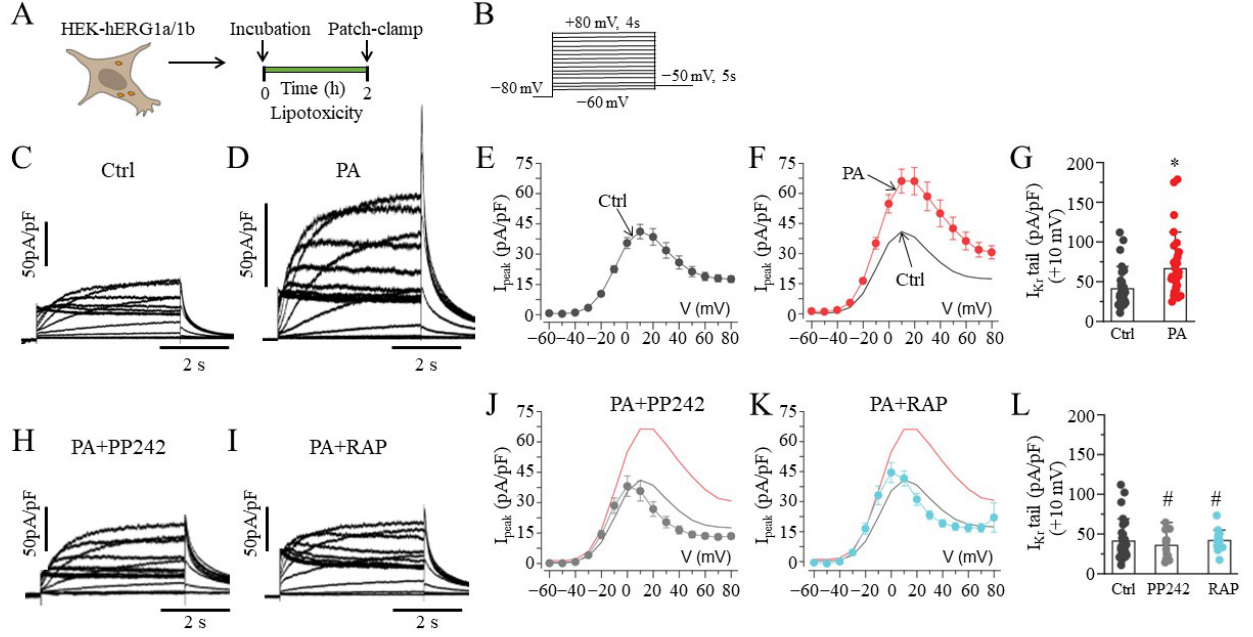
Figure 1. Electrophysiology of hERG1a/1b currents in lipotoxic HEK293 cells. ( A ) Experimental protocol: Macroscopic hERG1a/1b currents measured in HEK293 cells under control conditions and after pre-exposure to lipotoxicity for 2 h. ( B ) Voltage protocols used for evoking hERG1a/1b currents. Exemplar hERG1a/1b currents measured in control ( C ) and lipotoxic HEK293 cells ( D ). ( E – G ), Population I peak – V curves for hERG1a/1b currents and averaged data measured at +10 mV under the indicated conditions. Arrows indicate pooled 1a/1b peak current in control and lipotoxic cells. ( H – L ), Representative traces, population I peak –V curves, and averaged data at +10 mV for currents measured in lipotoxic cells pre-exposed to PP242 ( , and grey line ) and RAP ( , and cyan line ), with the same format as ( C – G ). The I peak – V curves for hERG1a/1b currents measured in control cells ( black line ) and in cells pre-treated with lipotoxicity ( red line ) are shown for comparison. Data are shown as the mean ±S.E.M. (* statistical significance at p < 0.05; # statistical non-significance at p > 0.05).